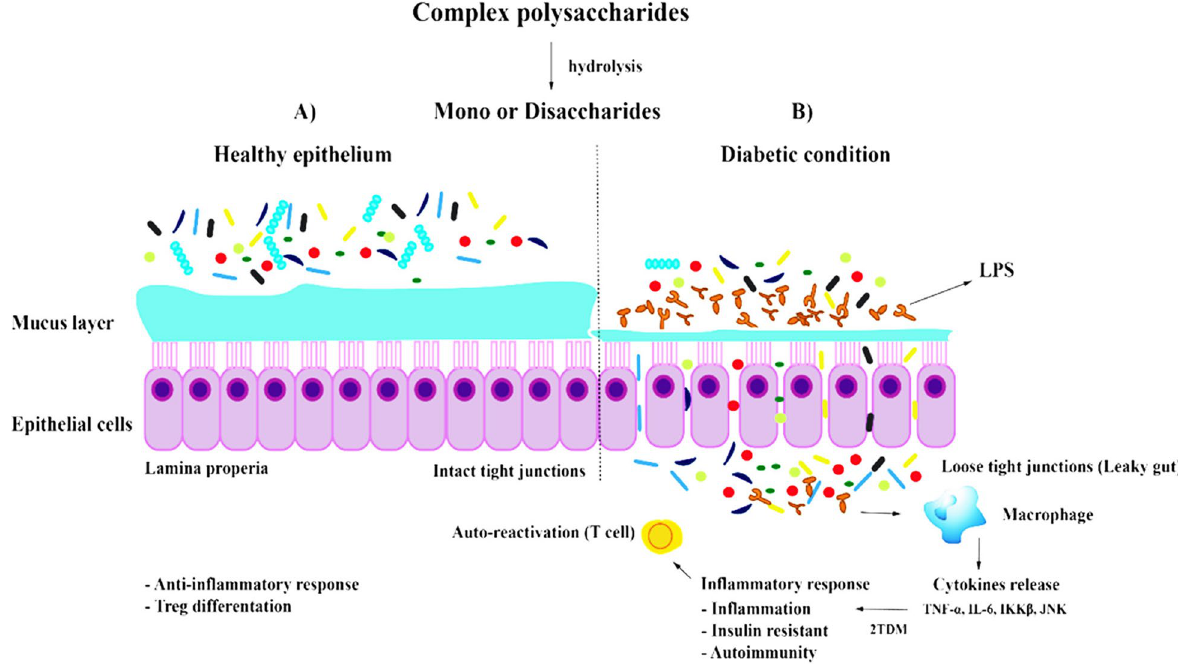
Fig. 1 Intestinal flora interrogating the mechanisms and pathways of Type 2 Diabetes